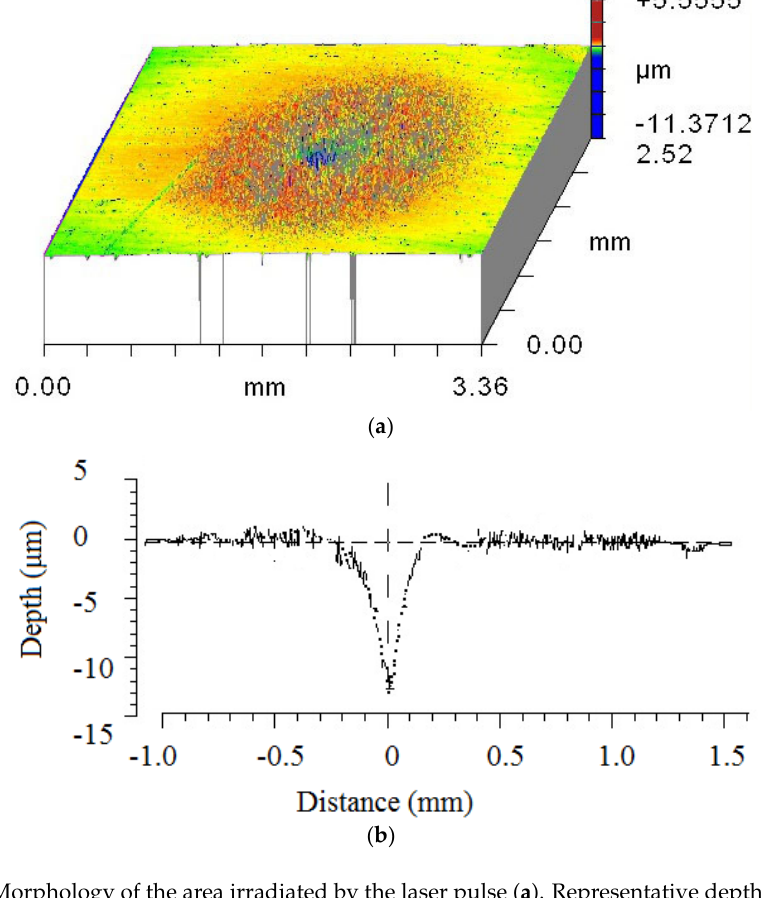
Figure 7. Morphology of the area irradiated by the laser pulse ( a ). Representative depth profile ( b ).